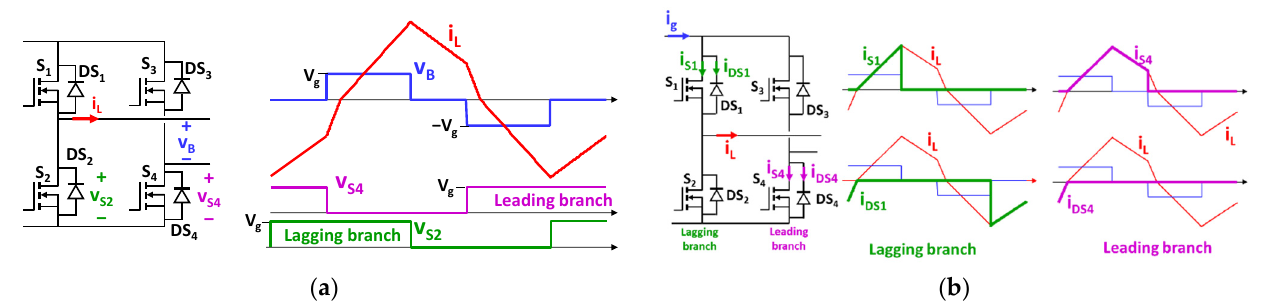
Figure 7. ( a ) Voltages at the midpoints of the branches. ( b ) Currents through the semiconductors of the input